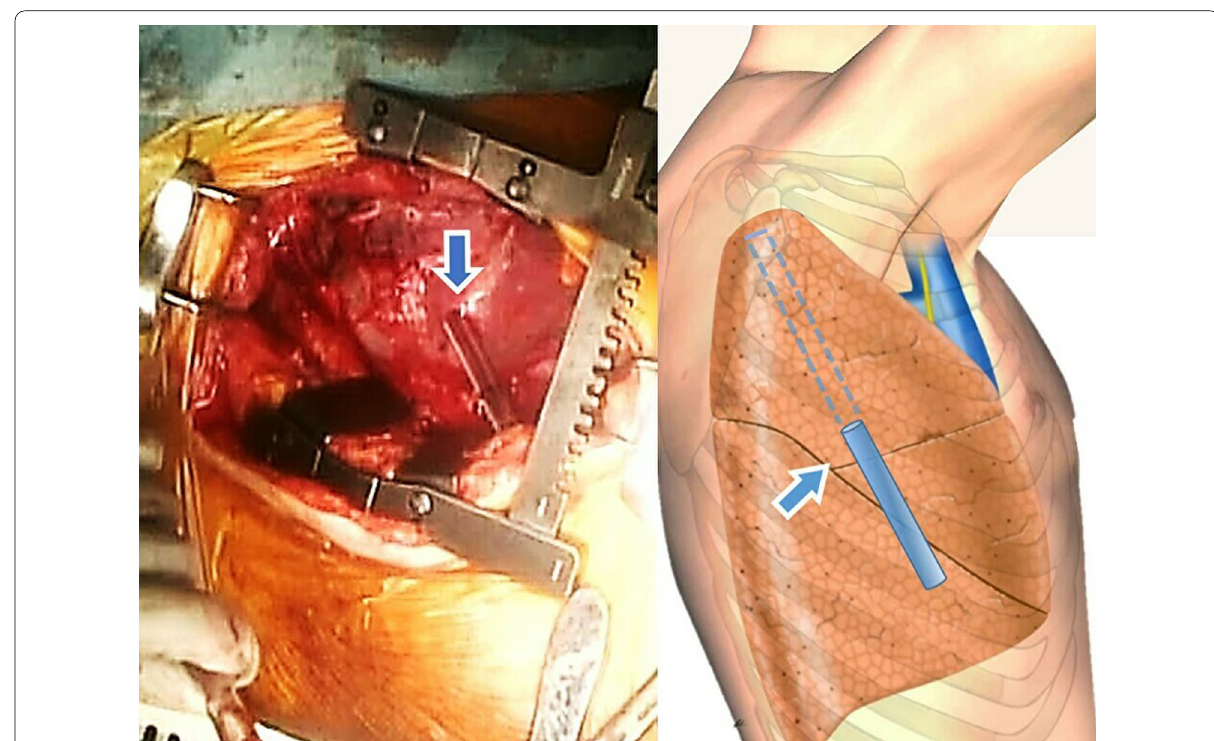
Fig. 2 Operative findings showing chest tube (arrows) stabbing the right upper lobe toward the apical portion, which has not completely penetrated through the lung but has extended to just under the visceral pleura